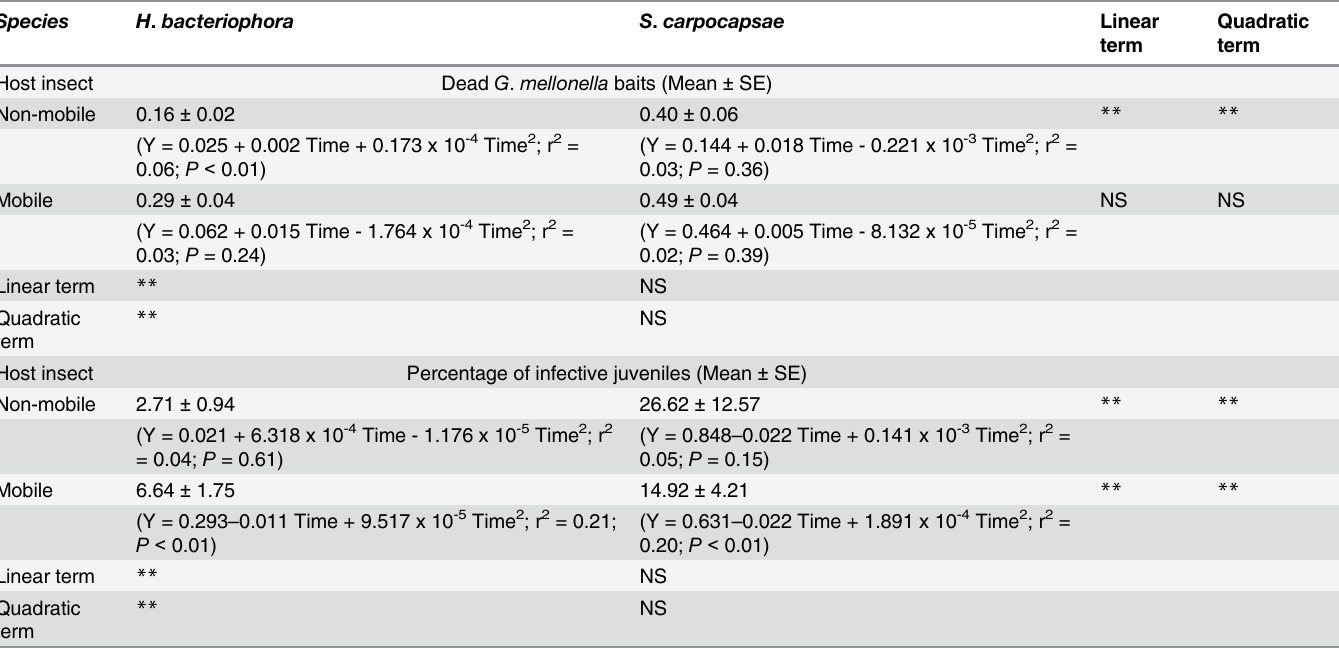
Mean ( ± SE) number of dead Galleria mellonella baits from the collected soil core samples and mean ( ± SE) percentage of infective juveniles (IJs) of Heterorhabditis bacteriophora and Steinernema carpocapsae dispersed to 2 cm wide annuli at all three distances, 3.8, 7.6 and 11.4 cm over a period of 12 to 72 hr in the presence of mobile and non-mobile host in the microcosms containing autoclaved fi eld soil with vegetation. Quadratic regression lines fi tted for the mean number of dead G . mellonella baits and mean percentage of IJs of each of the two species dispersed up to 11.4 cm distance from the source cadaver over a period of 72 hr in the presence of mobile and non-mobile hosts are bracketed. Double asterisk ( ** ) indicates the signi fi cant difference in the estimated linear and quadratic coef fi cients between the two species, horizontally and the type of host within a species, vertically (from regression analyses, P (cid:1) 0.05). NS = P >